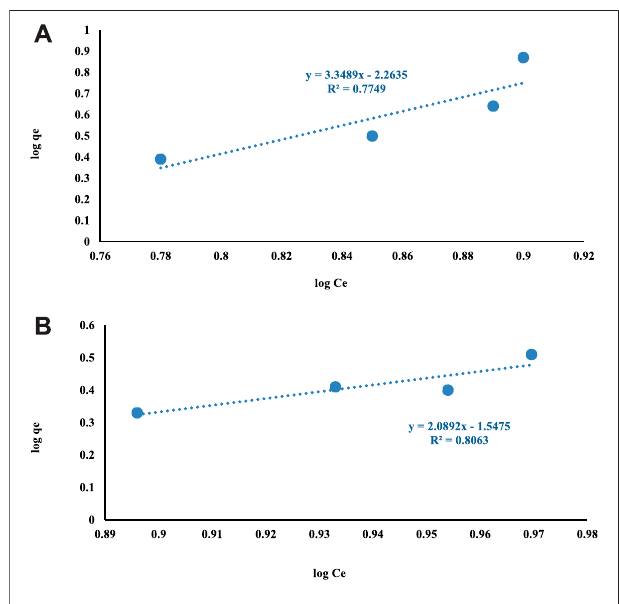
FIGURE 13 | Freundlich isotherm plot of adsorption (A) Chromium (B) Lead on OP/Se nanocomposite.